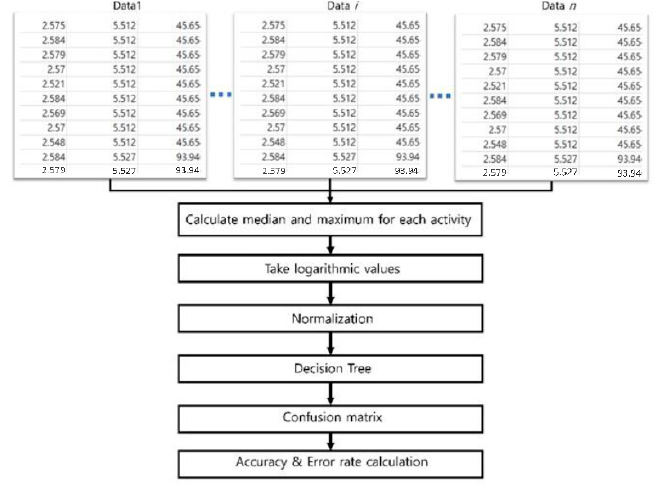
Figure 2. Flow chart for the estimation of activity patterns.